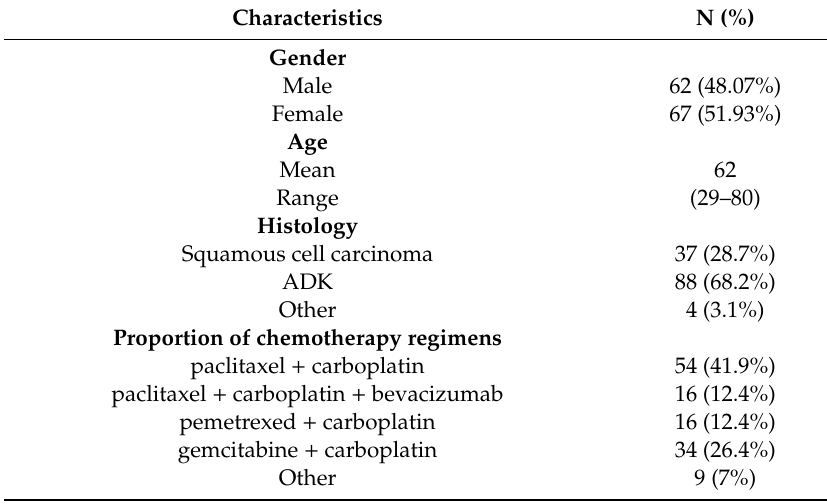
Table 2. Patients and their